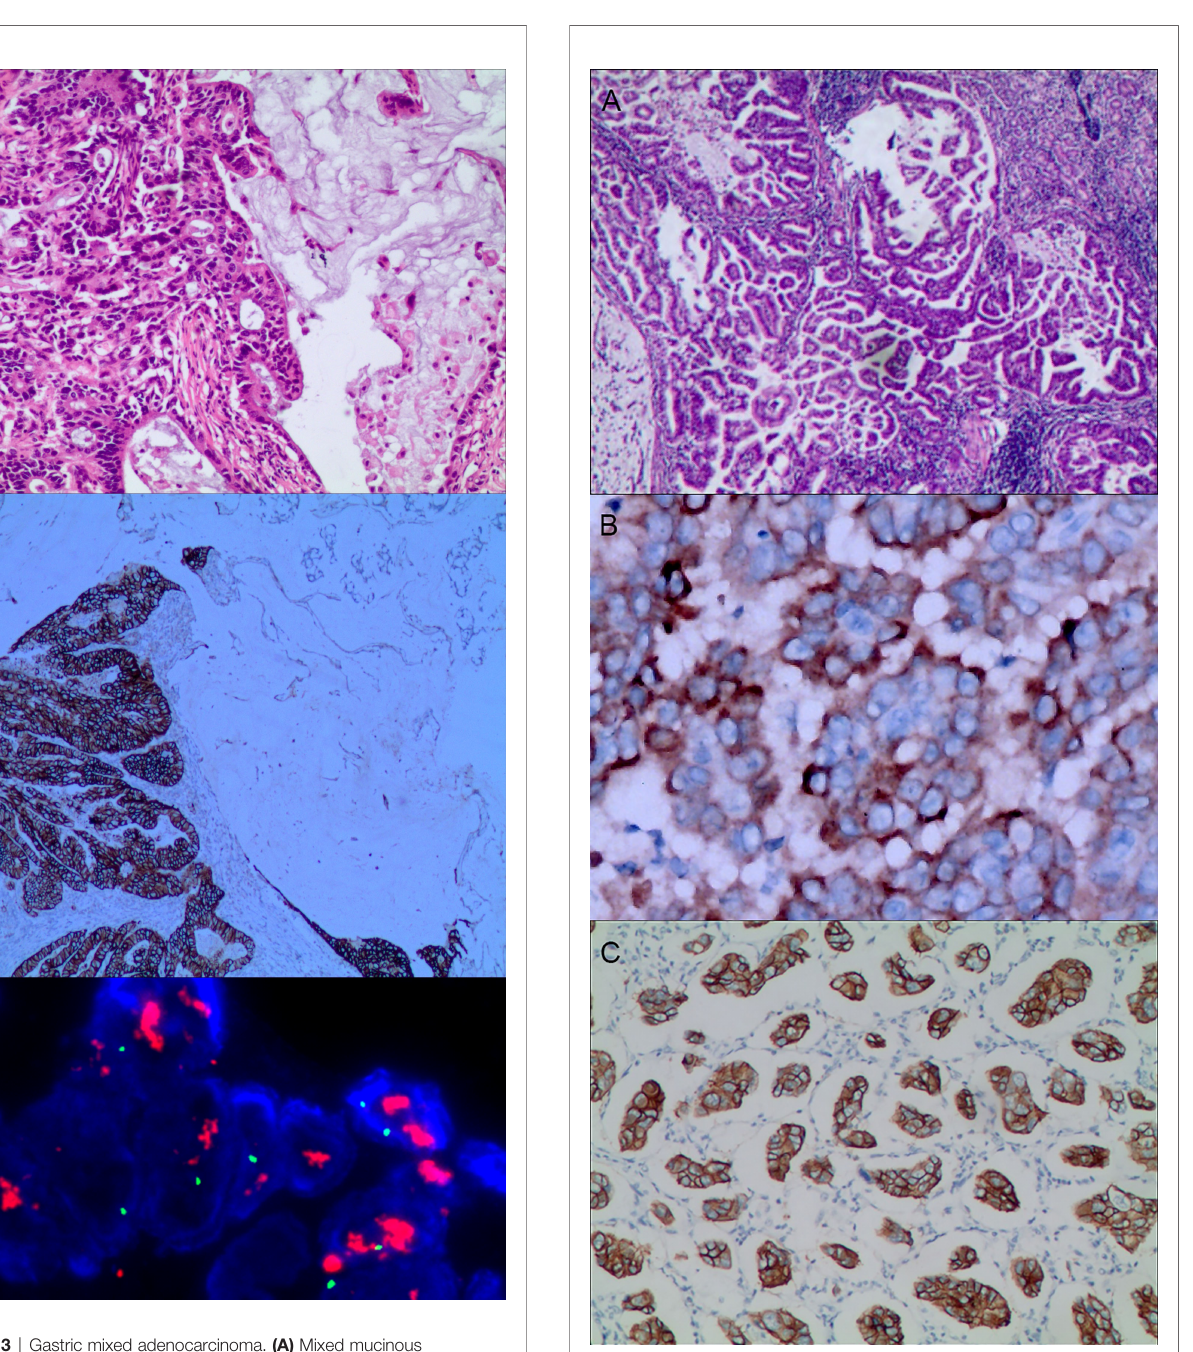
FIGURE 3 | Gastric mixed adenocarcinoma. (A) Mixed mucinous adenocarcinoma-papillary adenocarcinoma (70% mucinous adenocarcinoma/ 30% papillary adenocarcinoma), hematoxylin and eosin staining × 100. (B) HER2 protein expression. Papillary adenocarcinoma was partially 3+ positive. Mucinous adenocarcinoma was partially negative. En Vision method × 200. (C) FISH tests, papillary adenocarcinoma cluster ampli fi cation. Red represents the probe signal; green represents chromosome 17. FISH, fl uorescence in situ hybridization; HER2: human epidermalgrowth factor receptor-2.